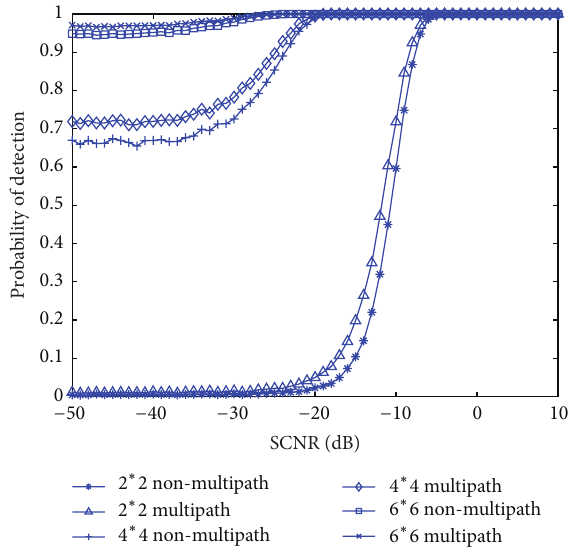
Figure 5: Comparison of GLRT-LQ detector and GLRT detector.